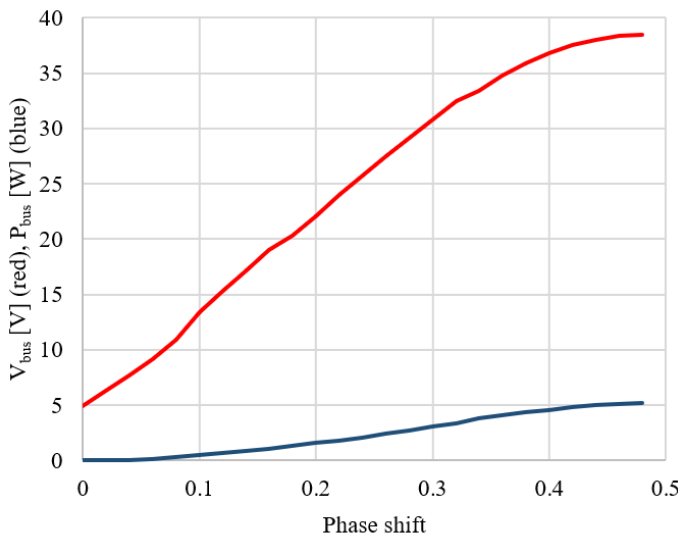
Figure 20. Experimental results of the voltage V bus and the power P bus versus one phase shift, with the other at zero constant value, V PV = 10 V, V bat = 0 V and R LOAD = 330 Ω